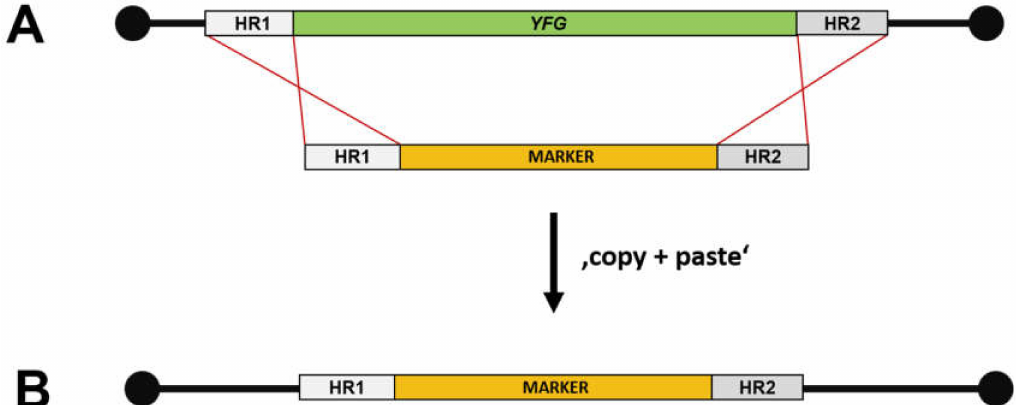
Figure 4. PCR-based gene targeting. ( A ) A disruption cassette with a selectable marker gene (MARKER) flanked by 5 (cid:48) - and 3 (cid:48) -homology regions (HR1, HR2) is obtained by PCR amplification and transformed into yeast cells. HR1 and HR2 direct recombination into the target locus of YFG (“your favorite gene”). ( B ) The marker cassette is now integrated into the